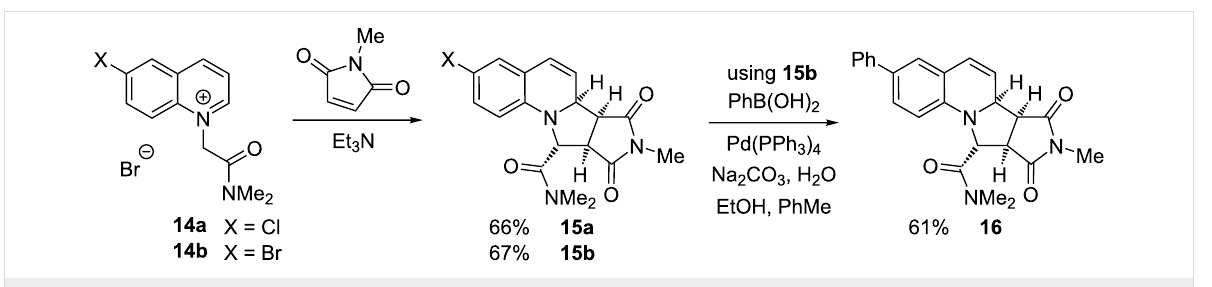
Scheme 5: Formation of amides 15a and 15b and Suzuki–Miyaura coupling to yield 16 .